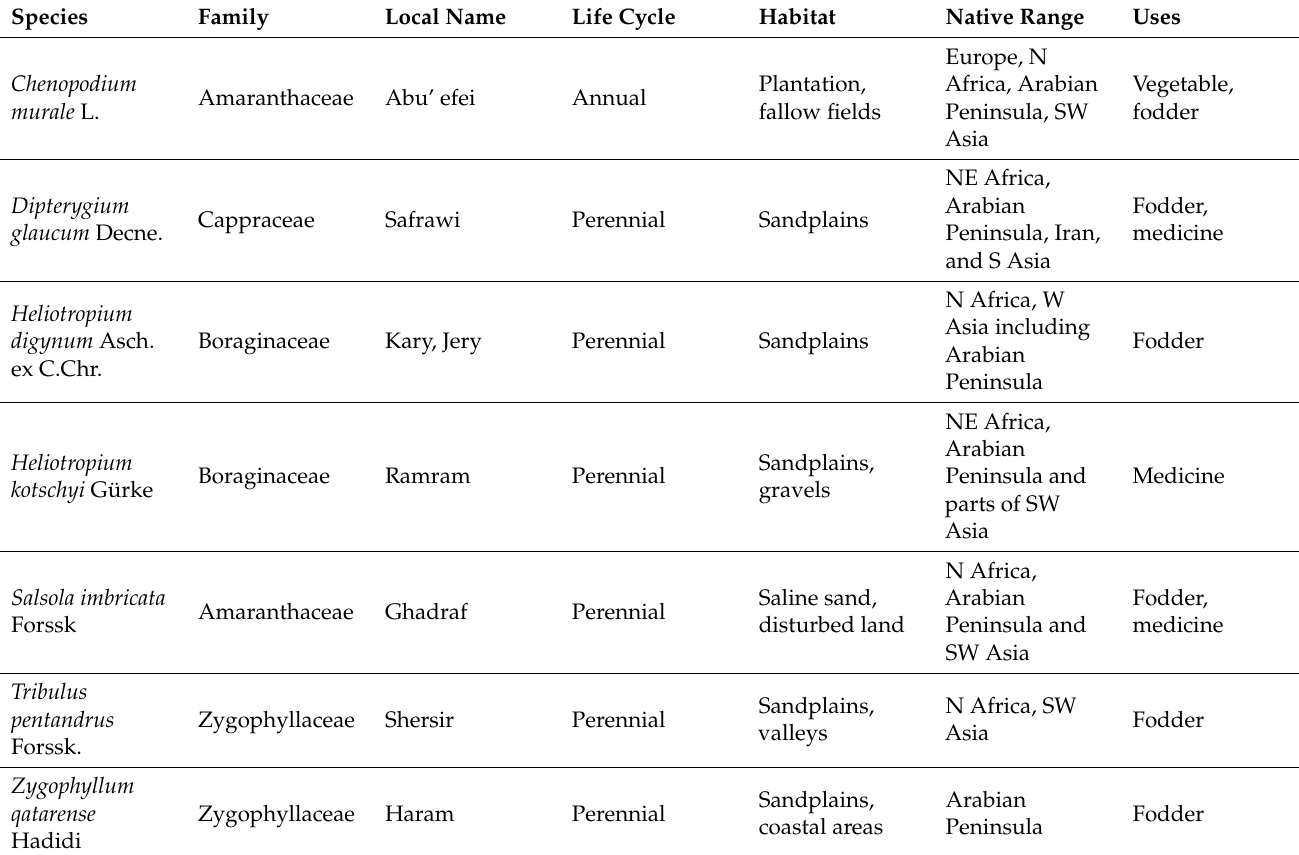
Table 5. Information on wild plant species analyzed for their nutritional